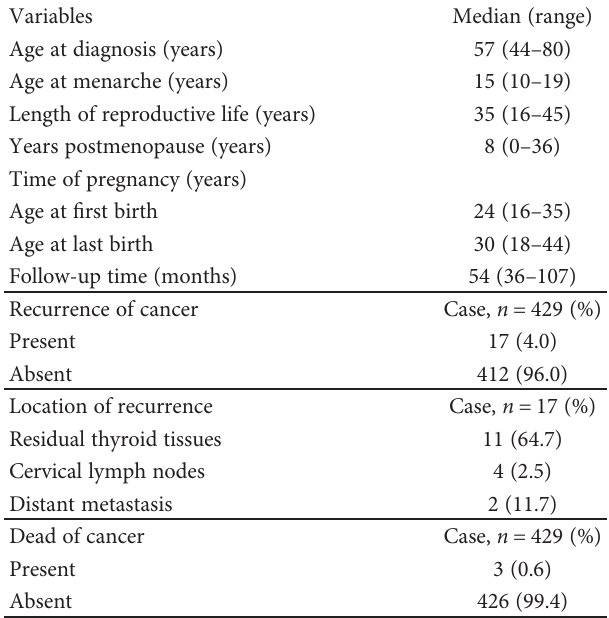
Table 1: Characteristics of the study